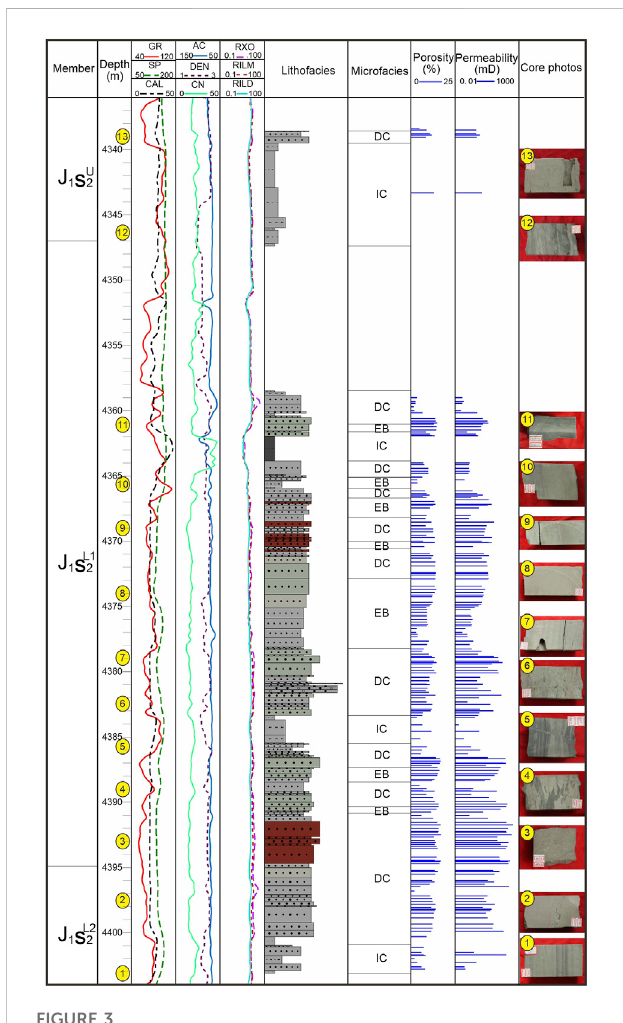
FIGURE 3 Single-wellhistogramofJ 1 s 2 inWellZhuang103intheMoxizhuang area (IC in the sedimentary microfacies column represents the interchannel, DC represents the distributary channel, and EB represents the estuary